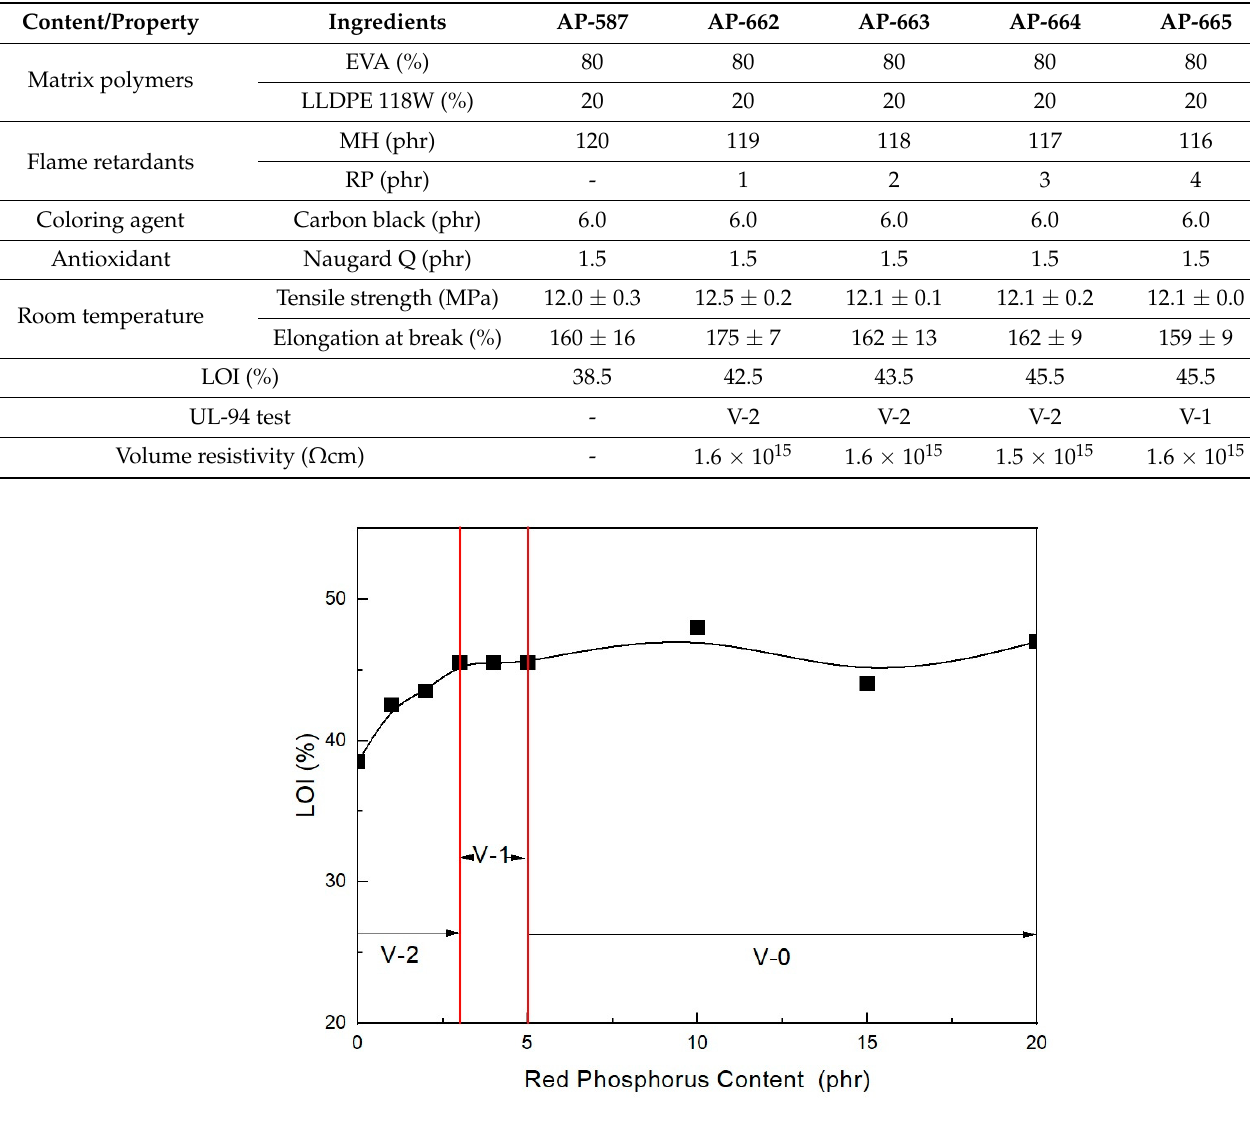
Figure 2. Flame retardancy of EVA/LLDPE 118W/120 phr flame-retardant (MH + RP) formulations as a function of RP content.